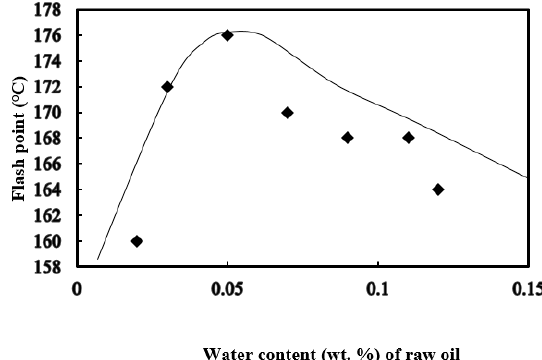
Figure 5. Effects of added water content in palm oil on the flash point of the biodiesel product.